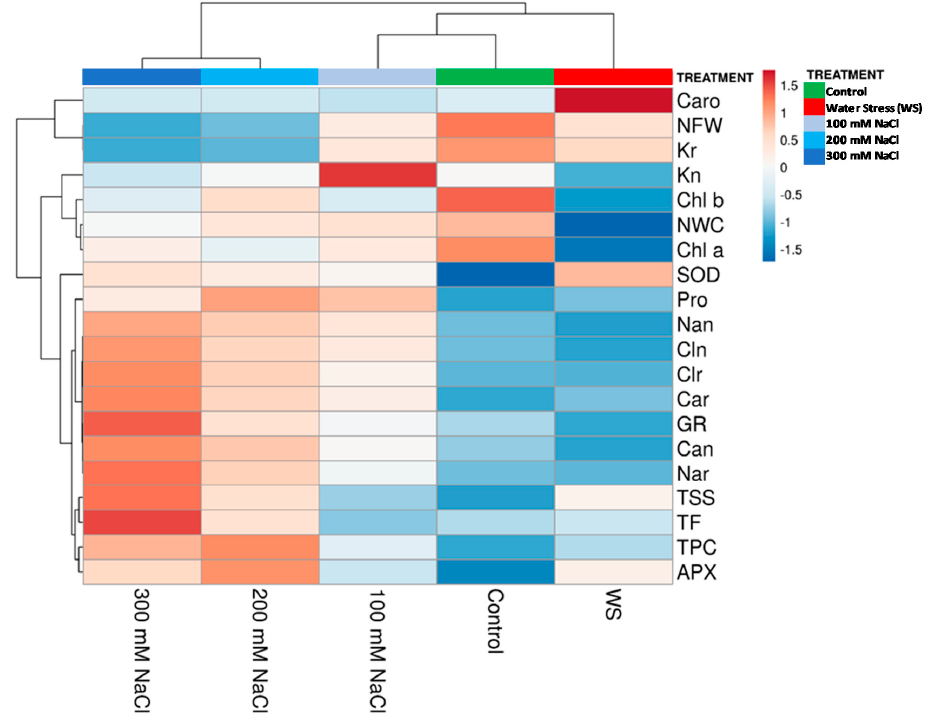
Figure 9. Hierarchical cluster analysis (HCA) and heatmap of growth, physiological and biochemical parameters displaying significant differences ( p < 0.05) in analysis of variance (ANOVA) tests, in one-year-old A. alba seedlings after 30 days of water or salt stress treatments. NFW, needle fresh weight; NWC, needle water content; Chl a, chlorophyll a; Chl b, Chlorophyll b; Caro, total carotenoids; Nan, sodium in needles; Cln, chloride in needles; Can, calcium in needles; Kn, potassium in needles; Nar, sodium in roots; Clr, chloride in roots; Car, calcium in roots; Kr, potassium in roots; Pro, proline; TSS, total soluble sugars; TPC, total phenolic compounds; TF, total flavonoids; SOD, superoxide dismutase activity; APX, ascorbate peroxidase activity; GR, glutathione reductase activity.